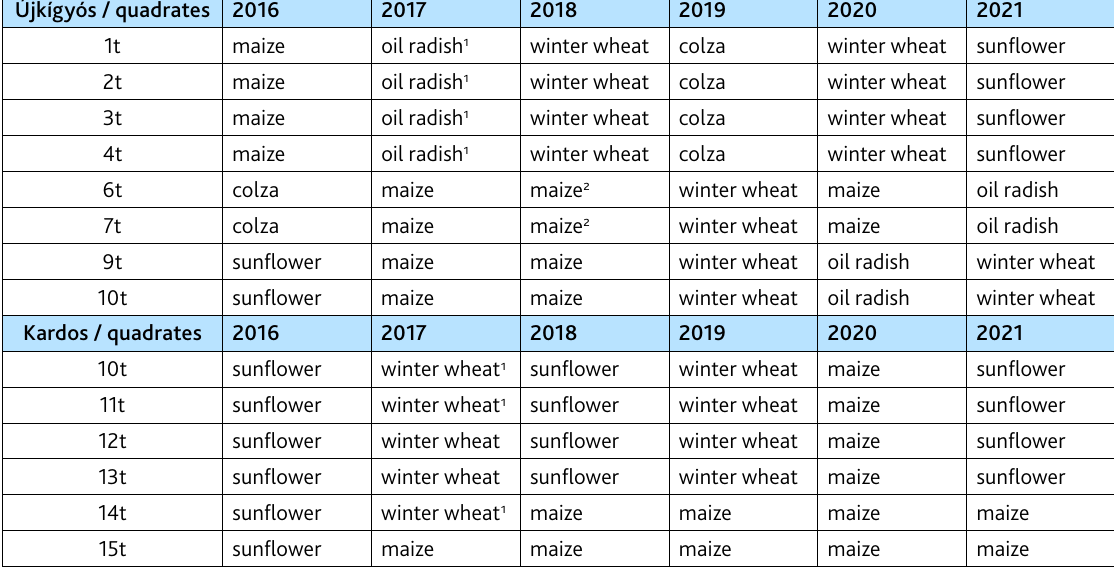
Table 2. Crops produced in quadrates of Kardos and Újkígyós parcels between 2016–2021 Újkígyós / quadrates 2016